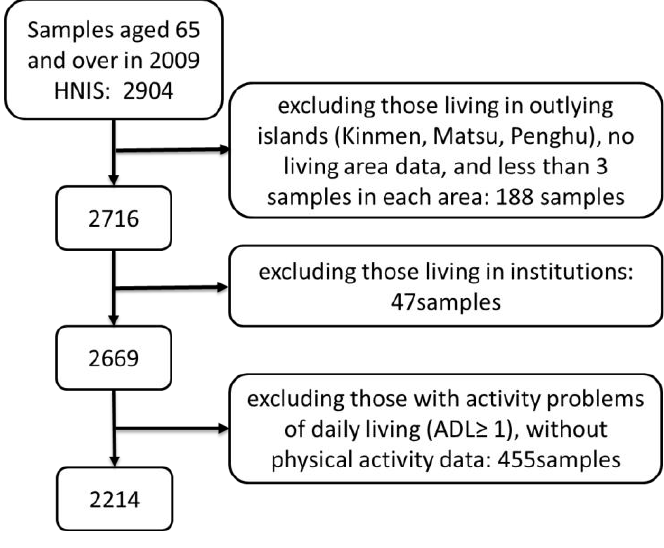
Figure 2. Participant enrollment procedure.